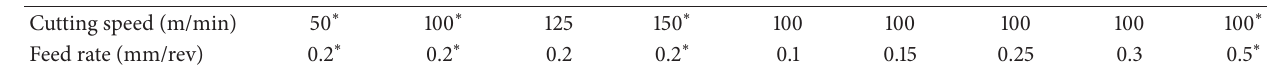
Table 2: Cutting parameter combinations used in cutting experiments for the uncoated tool (all values) and for the TiN coated tool (values marked with symbol ∗